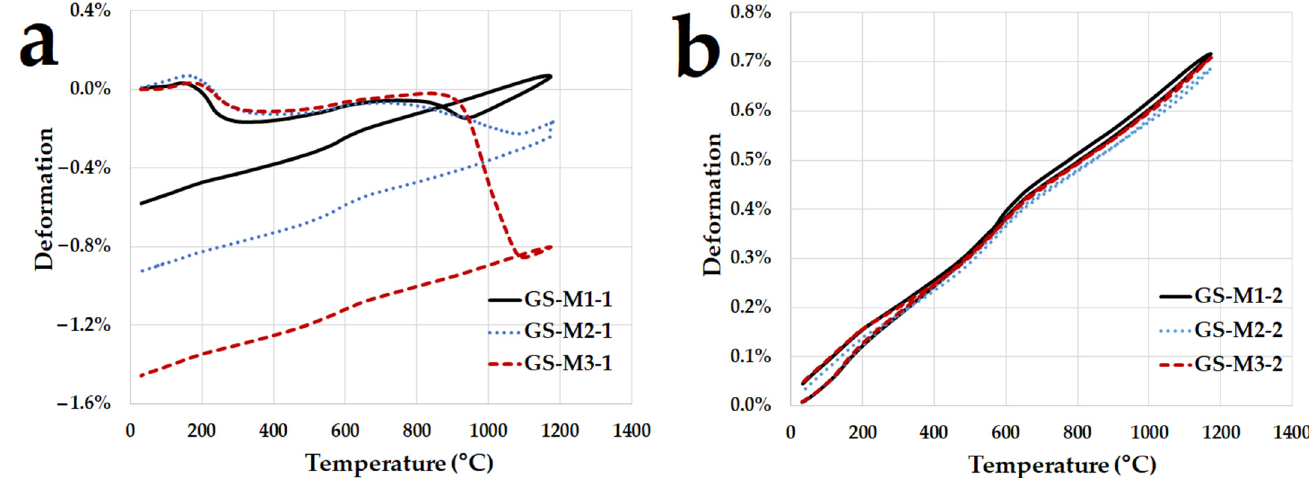
Figure 6. The dilatometric curves of first ( a ) and second ( b ) runs of geopolymer composites with different type of aluminosilicate up to 1200 °C (5 °C/min).